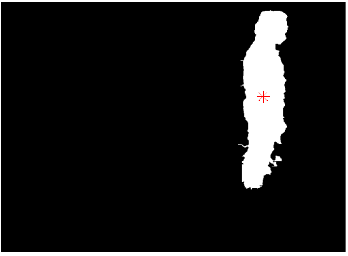
Figure 3. Centroid position of extracted human